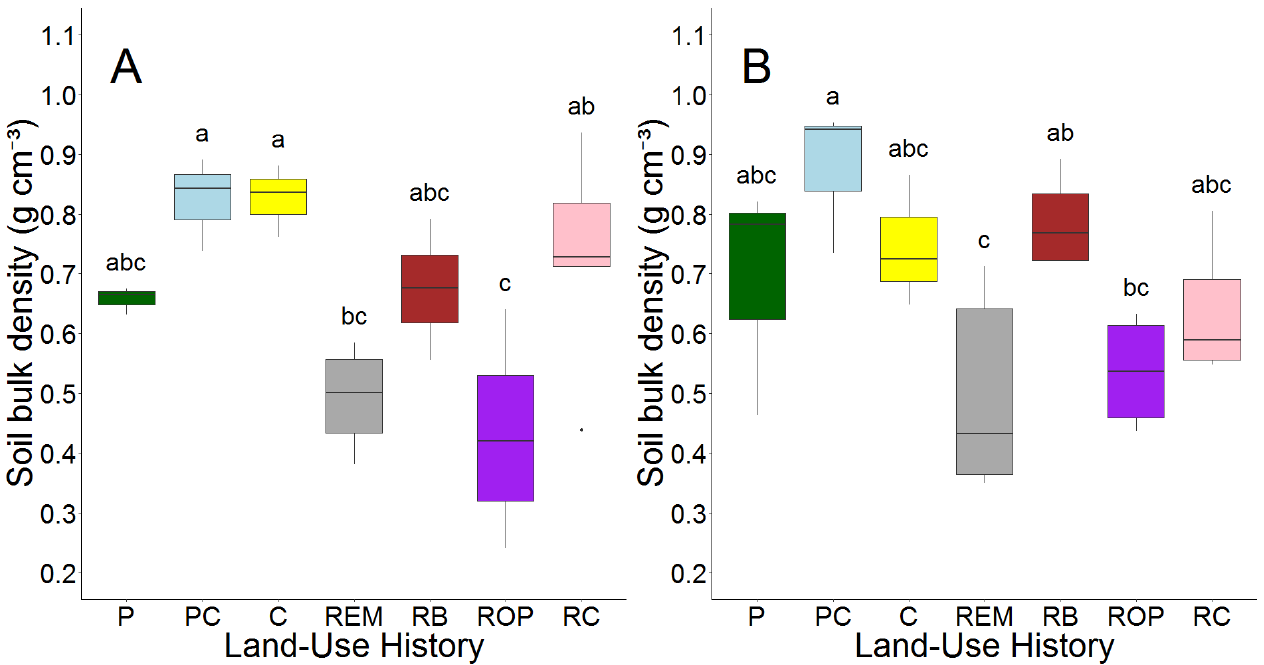
Figure 2. Soil bulk density (g cm⁻ 3 ) in 2008 ( A ) and 2018 ( B ) by land-use history. Letters represent results of Tukey’s post hoc test on one-way ANOVA, alpha = 0.05. Land-use histories are cow pasture (P), cow pasture converted from row crop (PC), row crop fields (C), remnant prairie (REM), bison prairie restored from P and PC pastures (RB), prairie restored from old pasture (ROP), and prairie restored from row crop (RC).